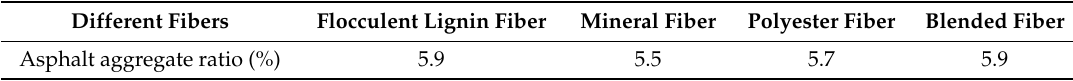
Table 7. Asphalt aggregate ratio of SMA mixtures with different fibers.